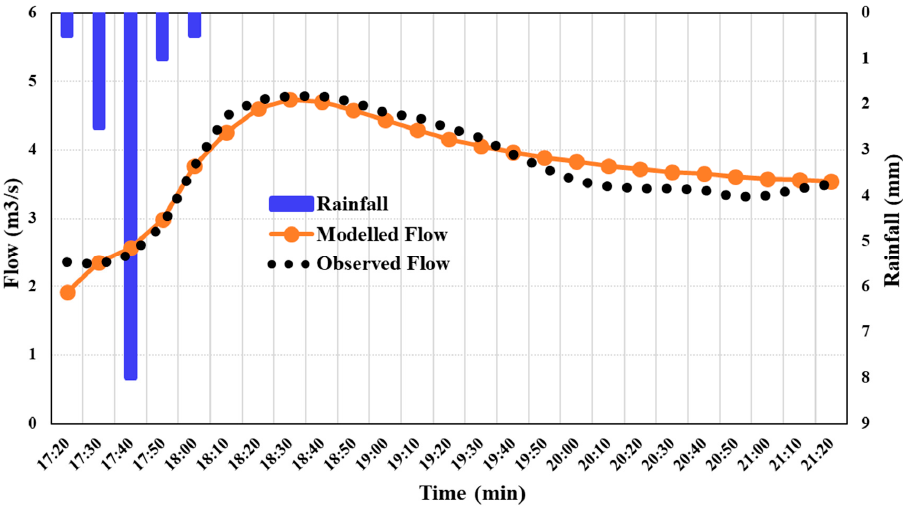
Figure 5. Calibration of the model for the rainfall on 20 September 2018 event.